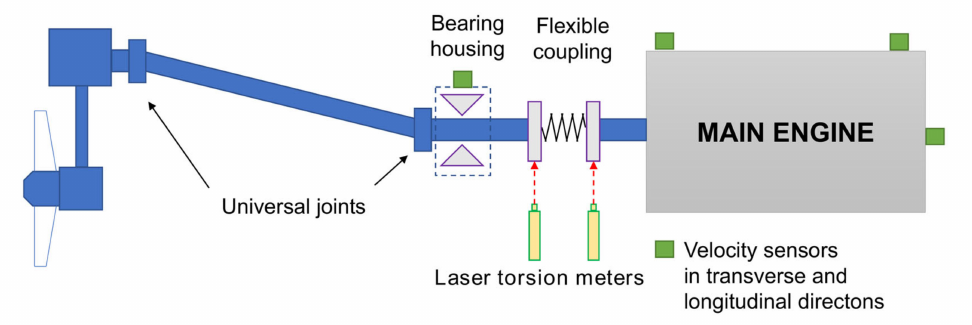
Figure 2. Equipment installation positions for global vibration measurement.